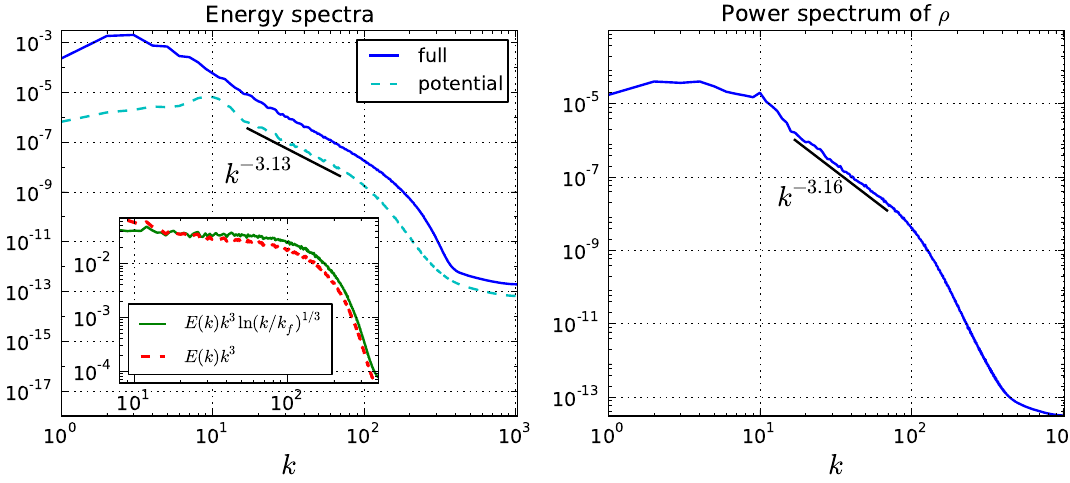
Figure 6 . (Left): Newtonian energy spectra of the inverse-cascade simulations plotted on a log-log scale. The spectra corresponding to the full velocity (cid:12)eld (solid, blue) and the curl-free potential part (dashed, cyan) are displayed. A least-squares best (cid:12)t power law of the potential part (cid:24) k (cid:0) 3 : 13 over the range k 2 [17 ; 70] is displayed. The inset displays the full spectrum compensated by k 3 ln ( k=k f ) 1 = 3 (solid, green) or k 3 only (dashed, red), showing that the logarithmic correction provides a better (cid:12)t than the pure power law. (Right): the power spectrum of the energy density (cid:26) , with the best (cid:12)t power law of k (cid:0) 3 : 16 over the range k 2 [17 ; 70]